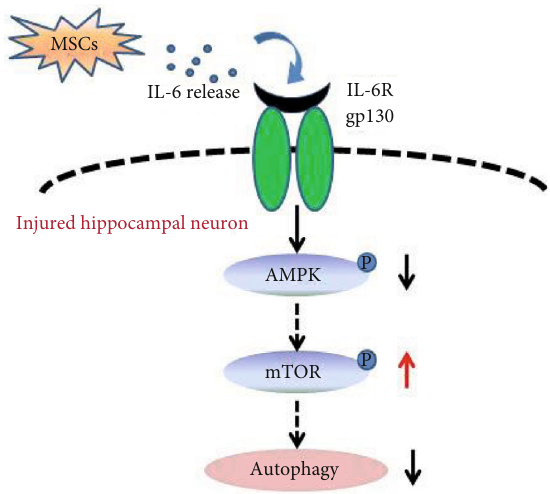
Figure 7: Summary diagram showing the role of IL-6 from MSCs in regulating hippocampal neuron autophagy in HIBD rats. In the current study, IL-6 from MSCs decreased p-AMPK protein expression levels to activate mTOR pathway phosphorylation, which in turn downregulated autophagy in the damaged hippocampal